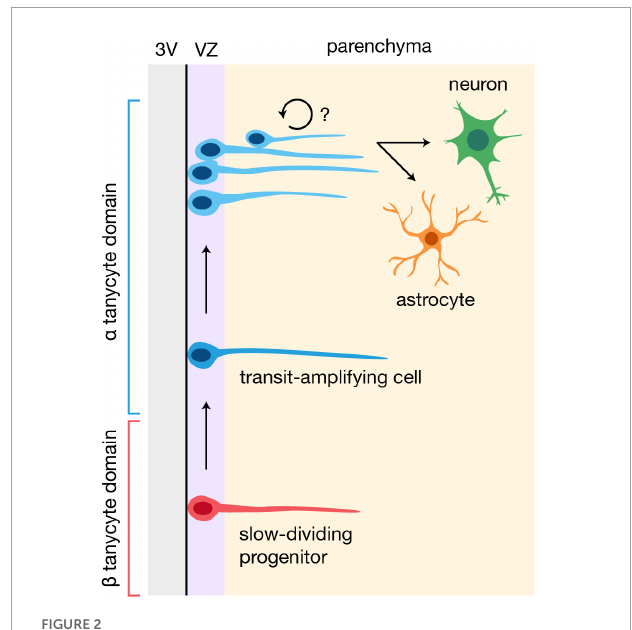
FIGURE2 Potential model of neurogenesis and gliogenesis in the postnatal hypothalamus. β tanycytes may constitute slow-dividing progenitors that give rise to highly proliferative, transit-amplifying α tanycytes, which then generate cells that migrate into the